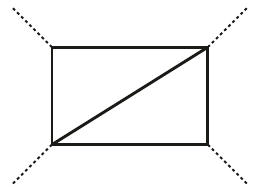
Figure 5 . Five-line box